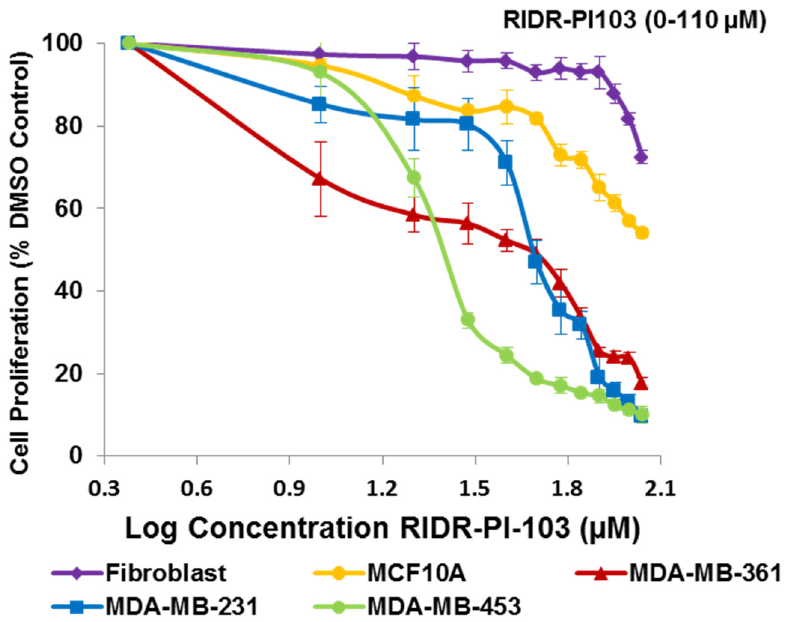
Figure 1. Dose response of RIDR-PI-103 in MCF10A, normal fibroblasts and breast cancer cells. NH fibroblasts, MCF10A, MDA-MB-231, MDA-MB-361 and MDA-MB-453 cells were plated in triplicate in 96 well plates and treated with RIDR-PI-103 (0–110 µ M) for 72 h. The data was analyzed and presented using GraphPad Prism v7 ( n = 3 independent experiments performed in triplicate ± SEM). IC50 values determined using graph pad prism as: Fibroblasts = N.D.; MCF10A = 78.6 µ M; MDA-MB-231 = 47.3 µ M, MDA-MB-361 = 43.01 µ M and MDA-MB-453 = 49.05 µ M.